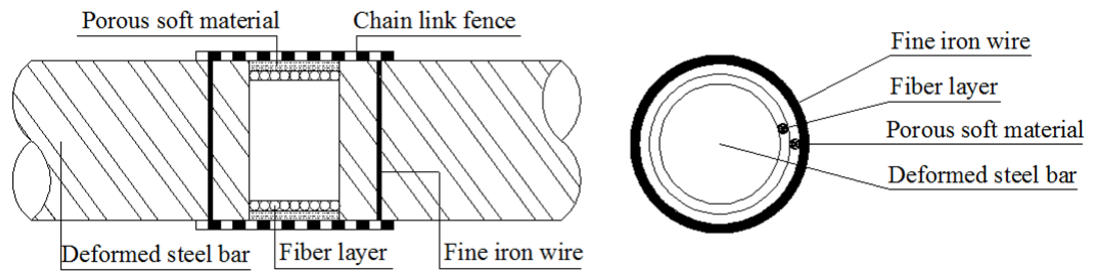
Figure 5. Packaging structure of BCES-I.